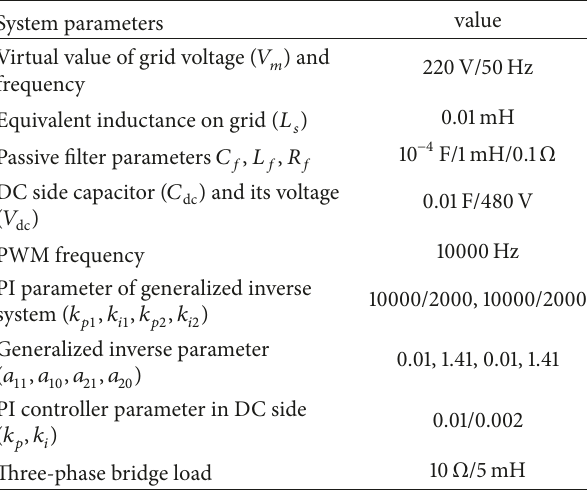
Table 1: SHAPF and controller